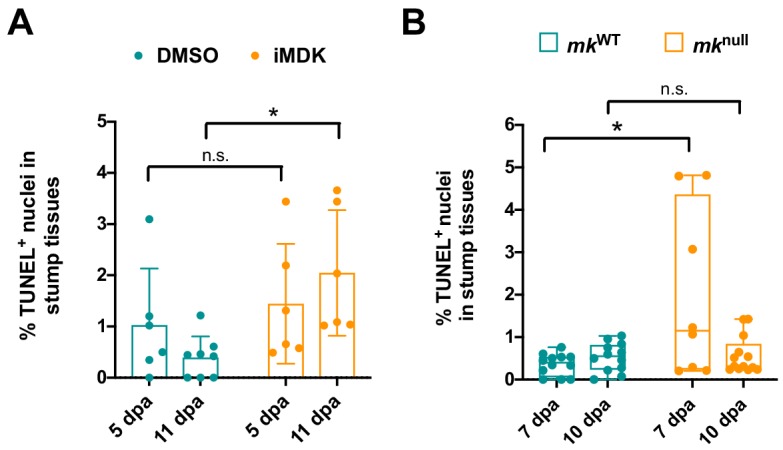
Mk is not required for blastemal cell survival.(A–B) Quantification of the percentage of TUNEL+ nuclei in blastemal cells of regenerating stump tissues in DMSO/iMDK-treated (5 dpa: N = 6 DMSO, 6 iMDK; 11 dpa: 8 DMSO, 6 iMDK) (A) or wildtype/mknull mutant (7 dpa: N = 12 mkWT, 8 mknull; 10 dpa: N = 12 mkWT, 13 mknull) (B) regenerating limbs reveals iMDK-treated limbs exhibit higher consistent levels of cell death, whereas mk mutant limbs are able to resolve cell death. Two-tailed unpaired t-tests were performed at each time point between the two conditions for statistical analysis. Graphs are mean ± SD. *p<0.05. n.s., not significant; dpa, days post-amputation.